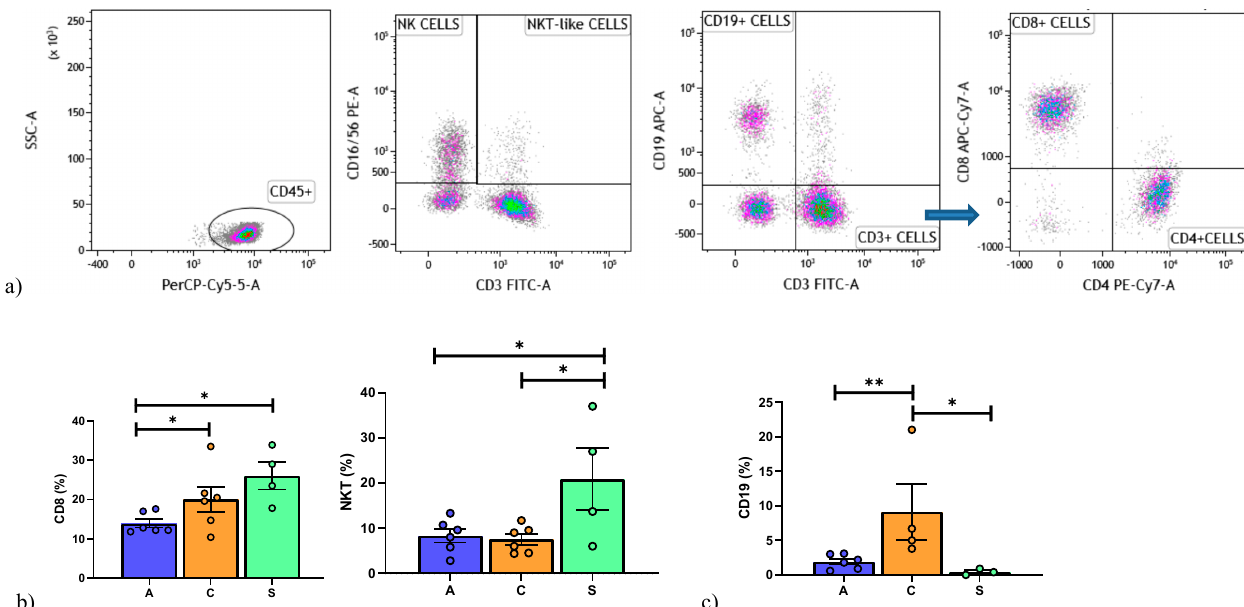
Figure 4. ( a ) Gating strategy used to analyze T cell subsets. ( b ) Data represent individual values on PBMC samples, mean Fig. 4. a) Gating strategy used to analyze T cells detection.. B) Data represent individual values on PBMC. mean (centre bar) ± SEM (upper and (center bar) ± SEM (upper and lower bars). If not indicated, p value is not significant. * p < 0.05, ** p < 0.01. ( c ) Data represent individual values on BAL samples, mean (center bar) ± SEM (upper and lower bars). * p < 0.05, ** p < 0.01. lower bars). If not indicated. p value is not significant. *p<0.05. **p<0.01. ***p<0.001. c) Data represent individual values on BAL samples. mean Abbreviations: A: acute, C: chronic, S: (centre bar)±SEM (upper and lower bars). *p<0.05. **p<0.01. ***p<0.001.